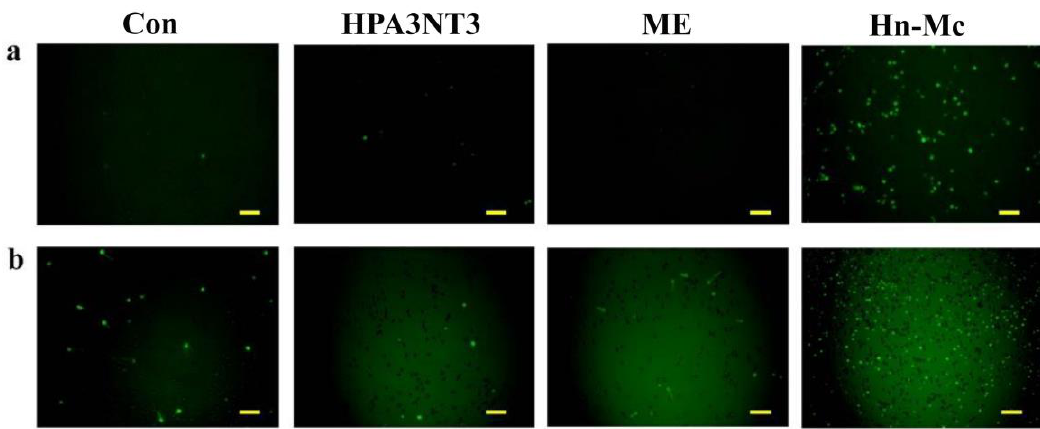
Figure 4. Intracellular reactive oxygen species (ROS) generation upon peptide treatment with C. tropicalis ( a ) and F. oxysporum ( b ). Fungal cells were incubated with 8 µ M of HPA3NT3, ME, and Hn-Mc for 2 h, stained with H2DCF-DA and analyzed using a fluorescence microscope. Scale bars, 10 µ